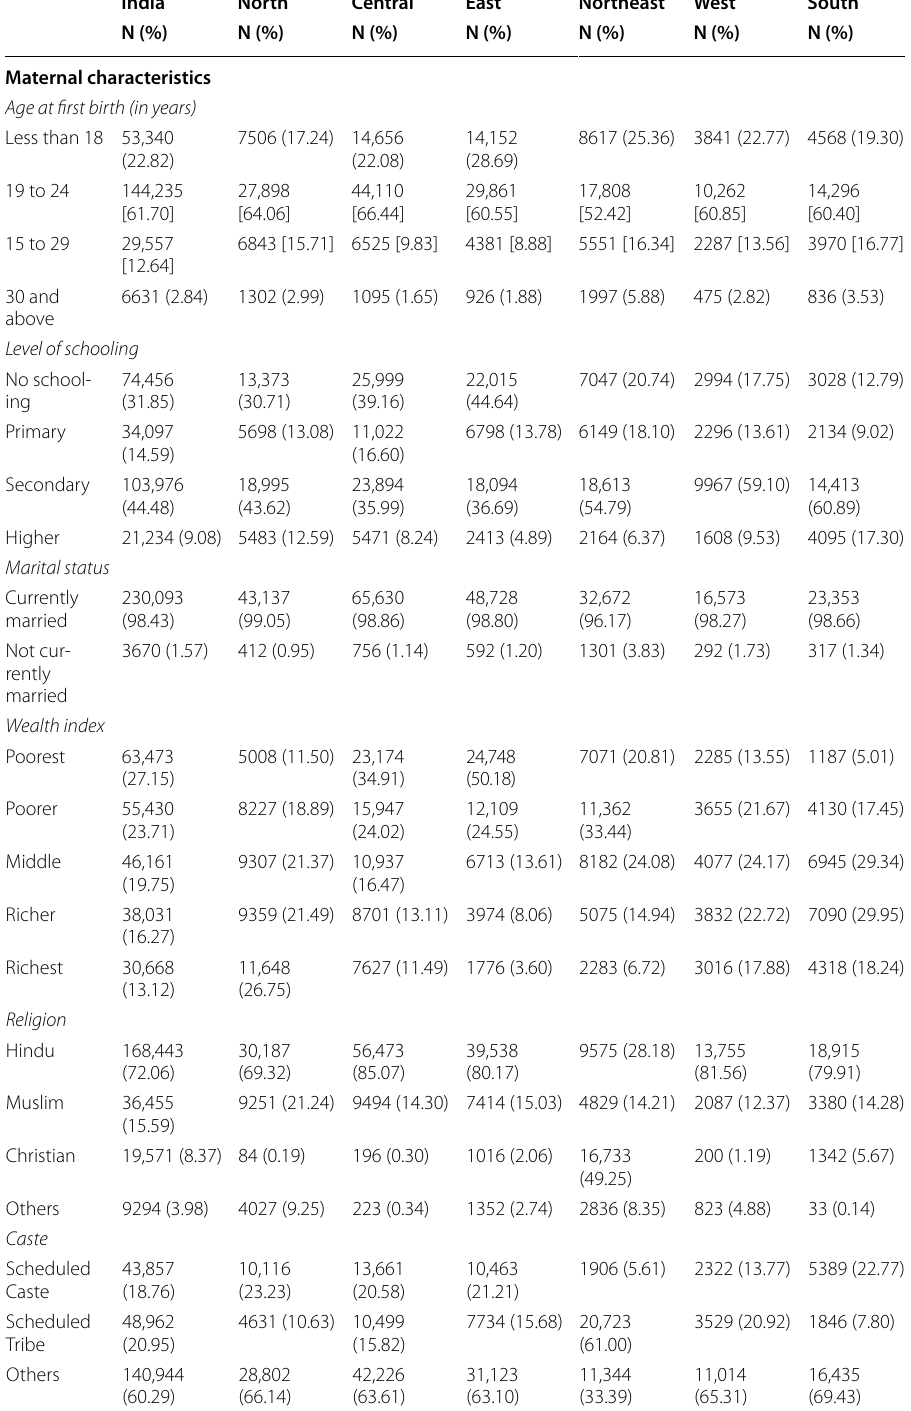
Table 1 Percentage distribution of 233,763 births by maternal and child characteristics for India and its six